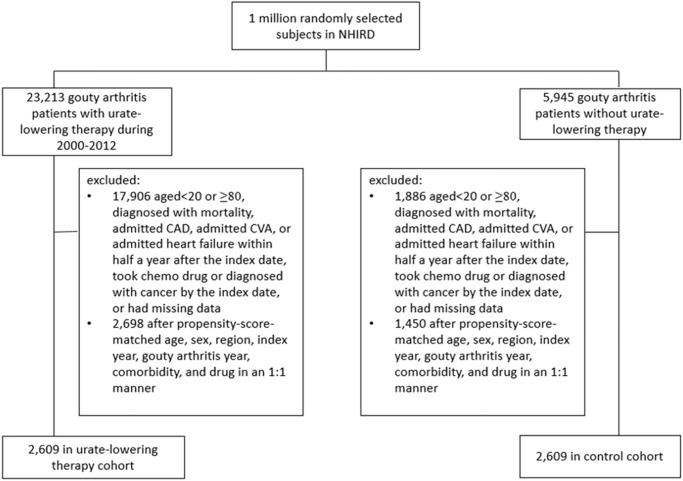
Flowchart of selecting the urate-lowering therapy cohort and the control cohort from the National Health Insurance Research Database.